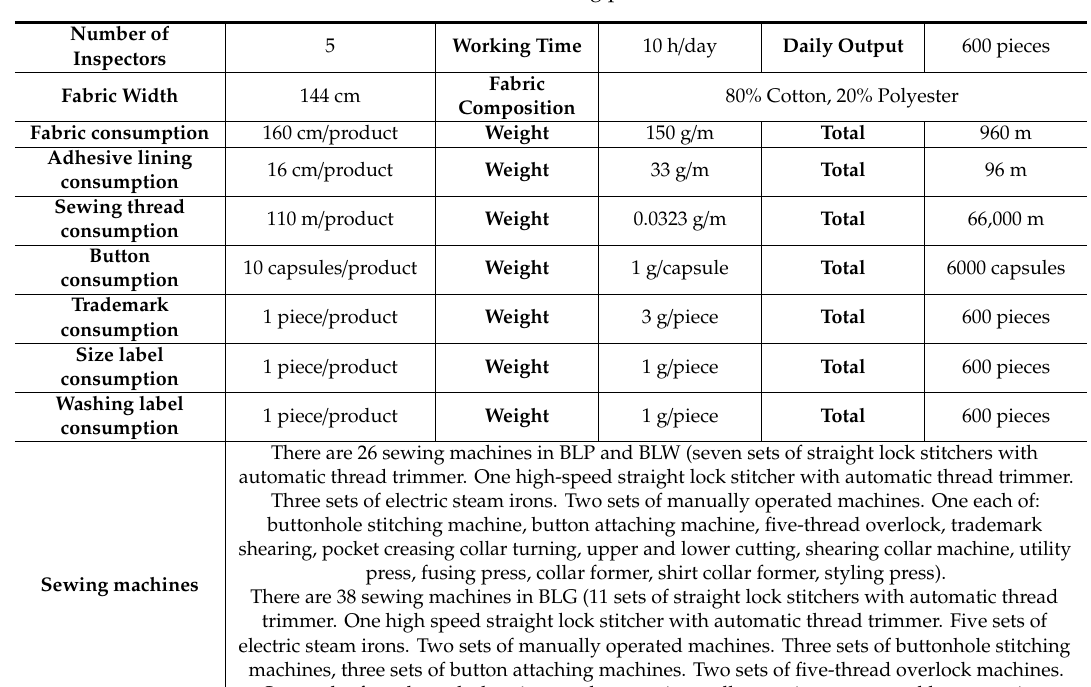
Table 5. Men’s shirt sewing production